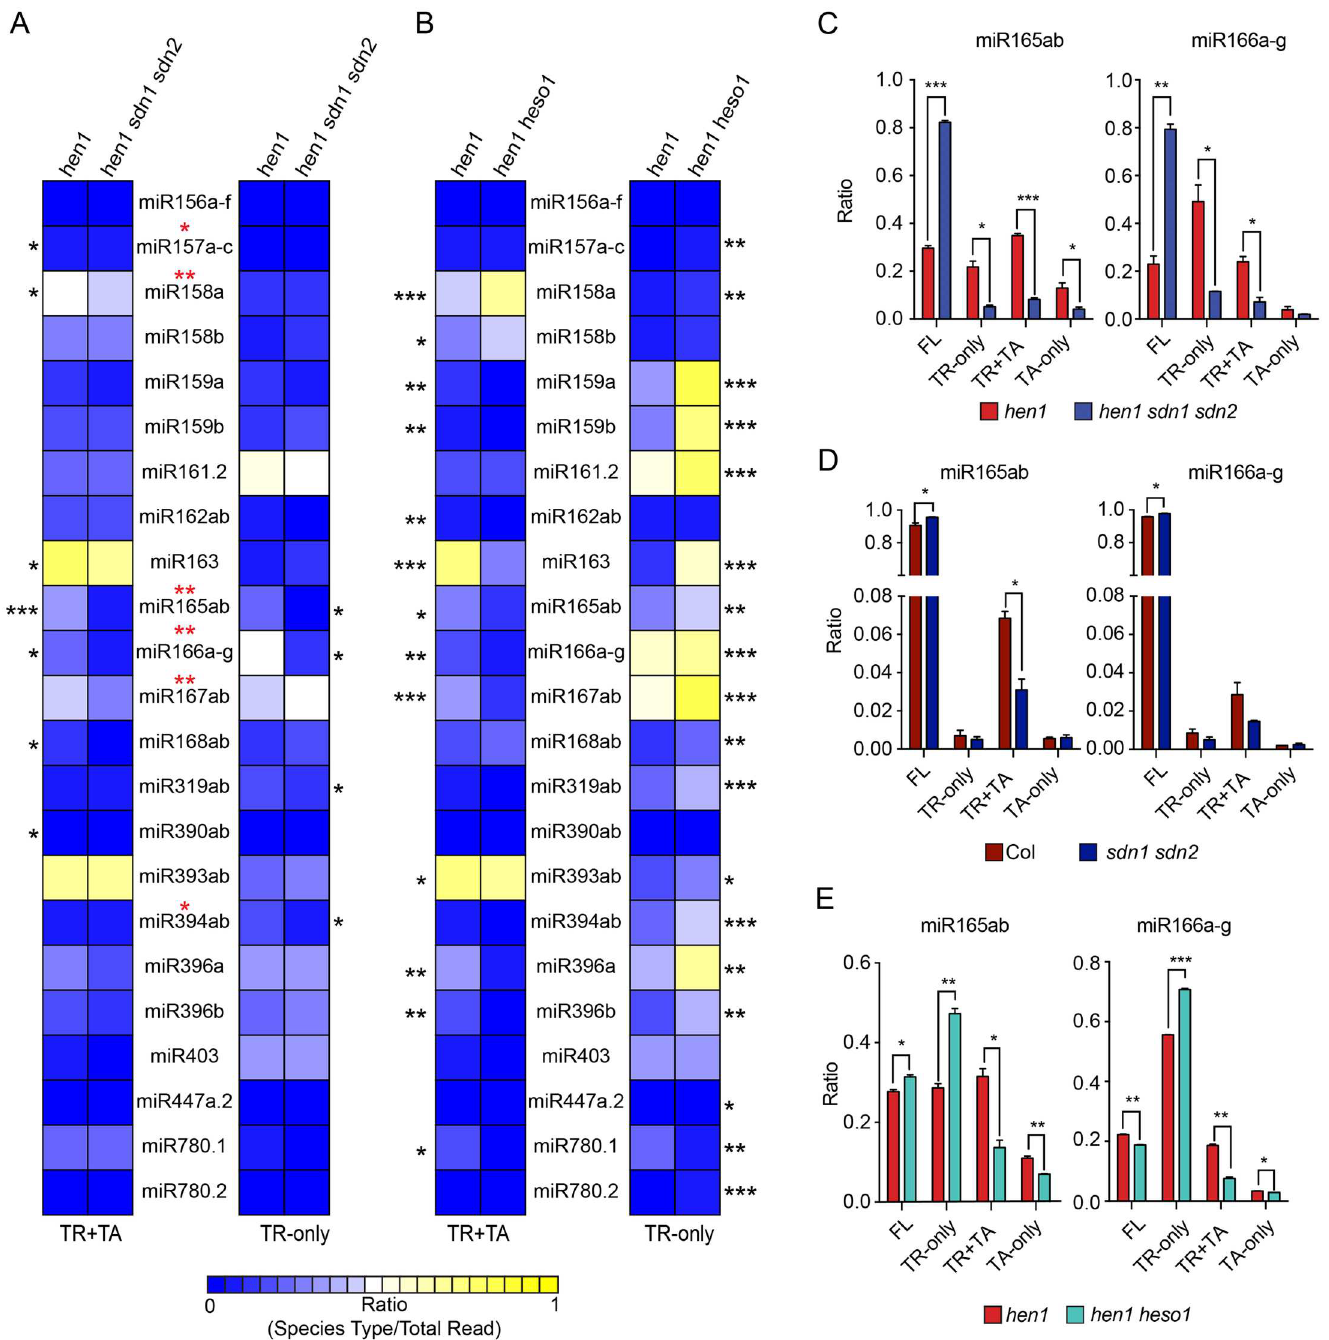
Fig 1. SDN1 and 2 are responsible for miRNA 3 0 truncation in vivo. High-throughput sequencing was conductedto profile miRNAs in wild type (Col), sdn1 sdn2 , hen1 ,and hen1 sdn1 sdn2 . PublishedsRNA-seq from hen1 and hen1 heso1 [29] was also analyzed.Two biologicalreplicates were performed for each genotype, and the error bars represent standarddeviations. * p < 0.05, ** p < 0.01, *** p < 0.001. (A-B) Heatmapsshowingthe levels of TR+TA and TR-only speciesof 23 miRNAs in hen1 sdn1 sdn2 (A) or hen1 heso1 (B) as compared to hen1 . For each miRNA, the ratio of TR+TA (or TR-only) species to all reads correspondingto this miRNA is shown. The red asterisks indicate statistically significantreductionin the sum of TR+TA and TR-only species for the indicatedmiRNAs (no miRNAs showeda statisticallysignificantincrease). (C-D) The composition of miR165and miR166reads corresponding to FL, TR-only, TR+TA, and TA-only species in hen1 , hen1 sdn1 sdn2 , Col, and sdn1 sdn2 , as indicated.(E) The composition of miR165 and miR166 reads in hen1 and hen1 heso1 .The reduction in the levels of TR+TA species in hen1 heso1 is accompanied by the increasein the levels of TR-only species. Underlyingdata can be found in the Gene ExpressionOmnibus (GEO) databaseas series GSE35479 and GSE58138. The raw data for panels(A-E) can be found in S1 Data.